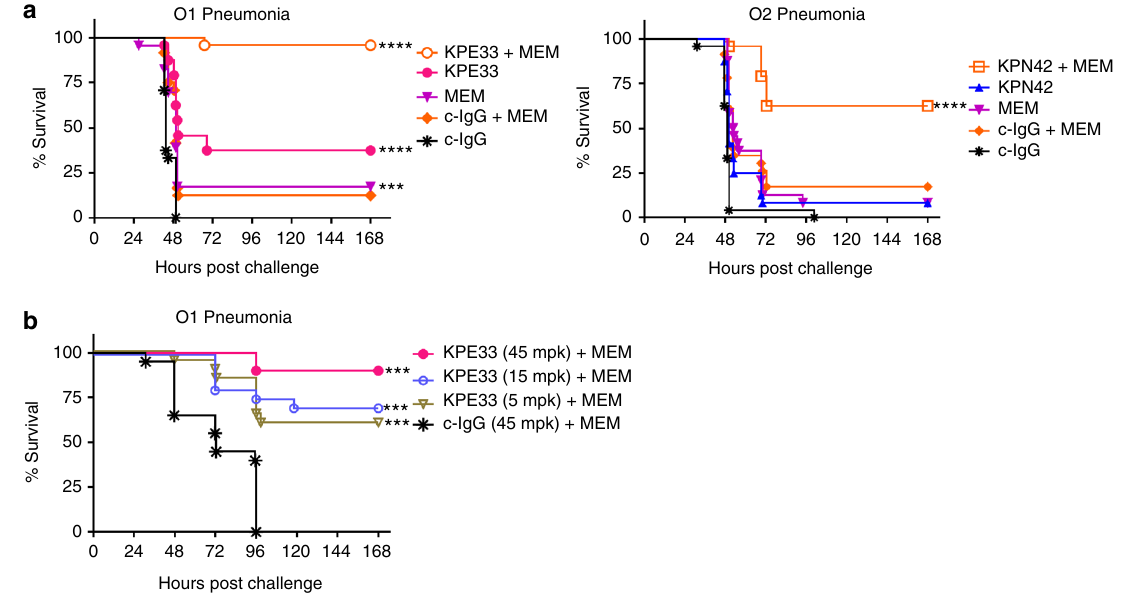
Fig. 6 Antibody synergy with antibiotic. a Mice were infected intranasally as in Fig. 5 with the K. pneumoniae O1 (Kp1131115, 6 × 10 7 CFU) or O2 (Kp961842, 2 × 10 8 CFU) strain then treated 1 h post infection with suboptimal doses of mAb (KPE33, 1 mg kg − 1 or KPN42, 0.2 mg kg − 1 given IV) and antibiotic (meropenem, 7.5 mg kg − 1 for O1 strain; 50 mg kg − 1 for O2 strain, given subcutaneous) or a combination of both mAb and antibiotic. Graphs represent the combined data from three separate experiments with a total of 24 mice in each group. Mantel-Cox analysis was done to assess signi fi cant survival bene fi t compared to the control mAb ( a ) or control mAb + MEM ( b ), **** p < 0.0001, *** p < 0.001, ** p < 0.01. The Bliss independence method was used to determine synergistic activity of the combination therapy vs. either monotherapy alone; p = 2.5 × 10 − 6 for KPE33+MEM combination and p = 7.7 × 10 − 5 for KPN42+MEM combination. b Mice were infected intransal with a KP O1 strain (Kp8045, 1 × 10 4 CFU). Meropenem (1.5 mpk) was administered subcutaneous 4 h post infection and mAb KPE33 was administered IV 24 h post infection at the indicated doses. All graphs are representative of at least three separate experiments. An isotype-matched mAb (c-IgG) was used as a negative control. Mantel-Cox analysis was done to assess signi fi cant survival bene fi t compared to the control mAb+MEM b , **** p < 0.0001, *** p < 0.001, ** p <